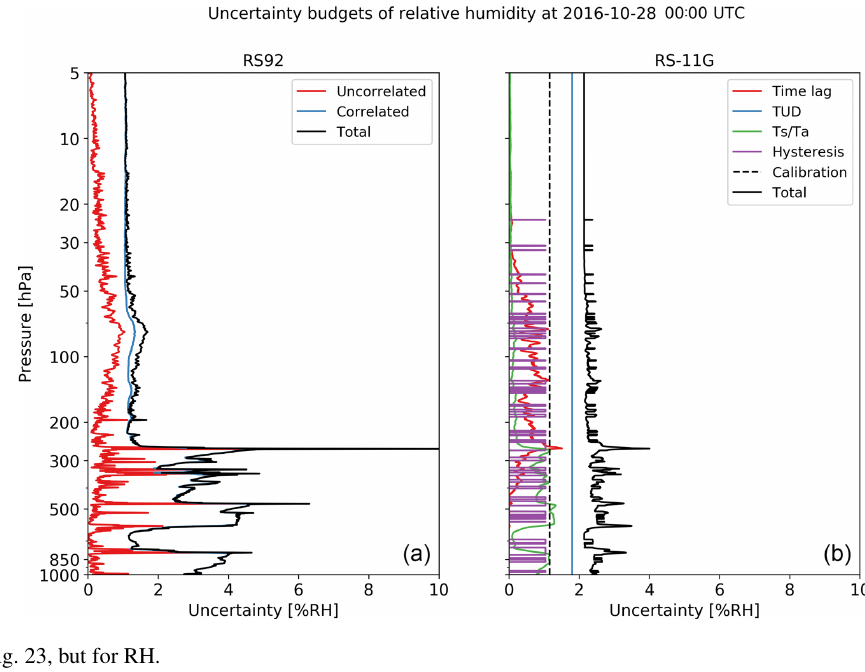
Figure 26. As per Fig. 23, but for RH.